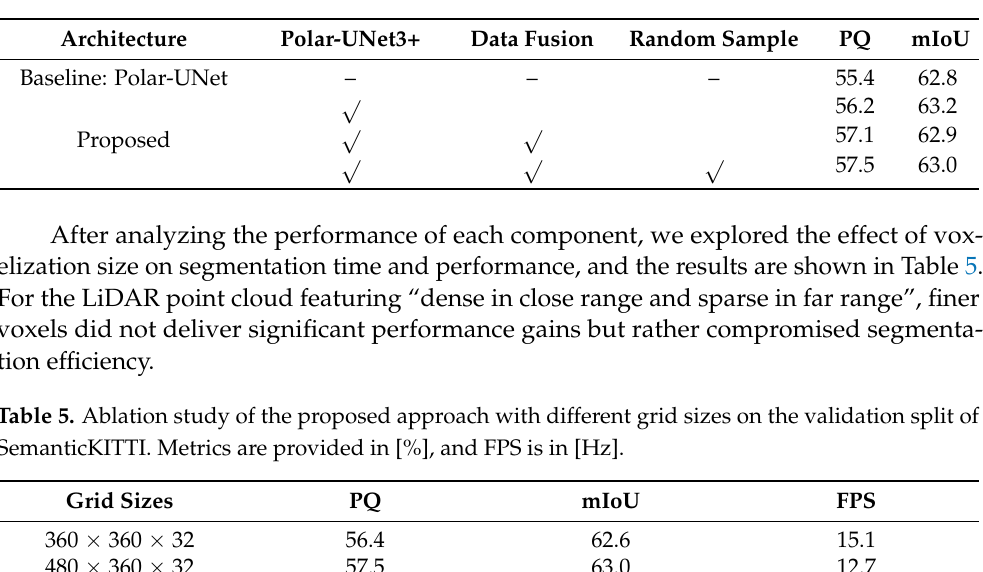
√ to represent each